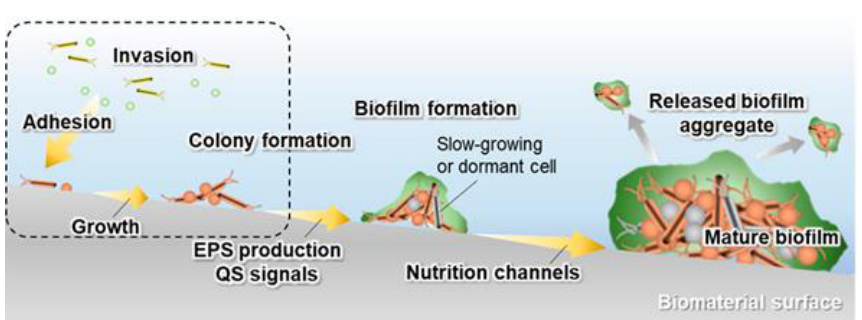
Figure 1. Schematic diagram of the biofilm formation process. The dashed area represents the initial stages of biofilm formation. Reproduced with permission from Ref. [30]. Copyright 2020, Multidisciplinary Digital Publishing Institute.